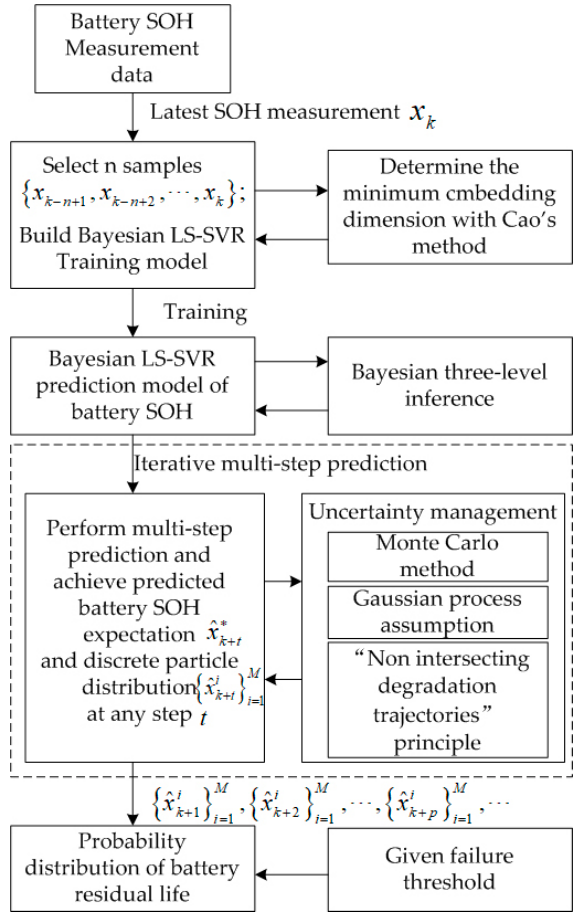
Figure 1. The prediction framework for the residual life of a lithium battery based on the Bayesian LS-SVR. SOH is State of Health.